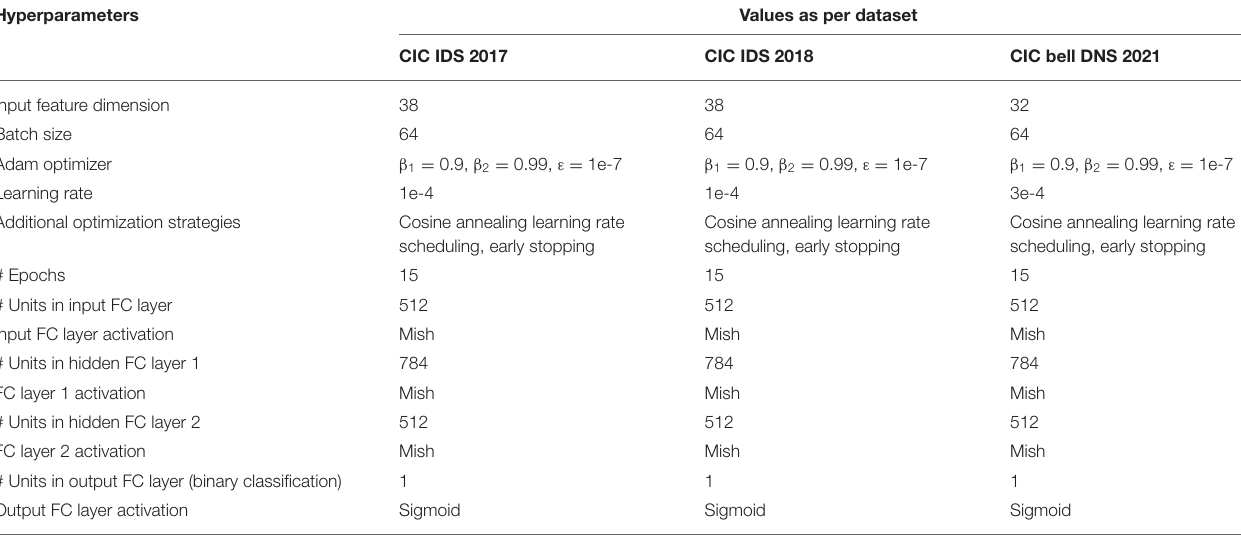
TABLE 5 | Hyperparameter details for ImmuneNet for CIC IDS 2017, CIC IDS 2018, and CIC Bell DNS 2021 datasets. Hyperparameters